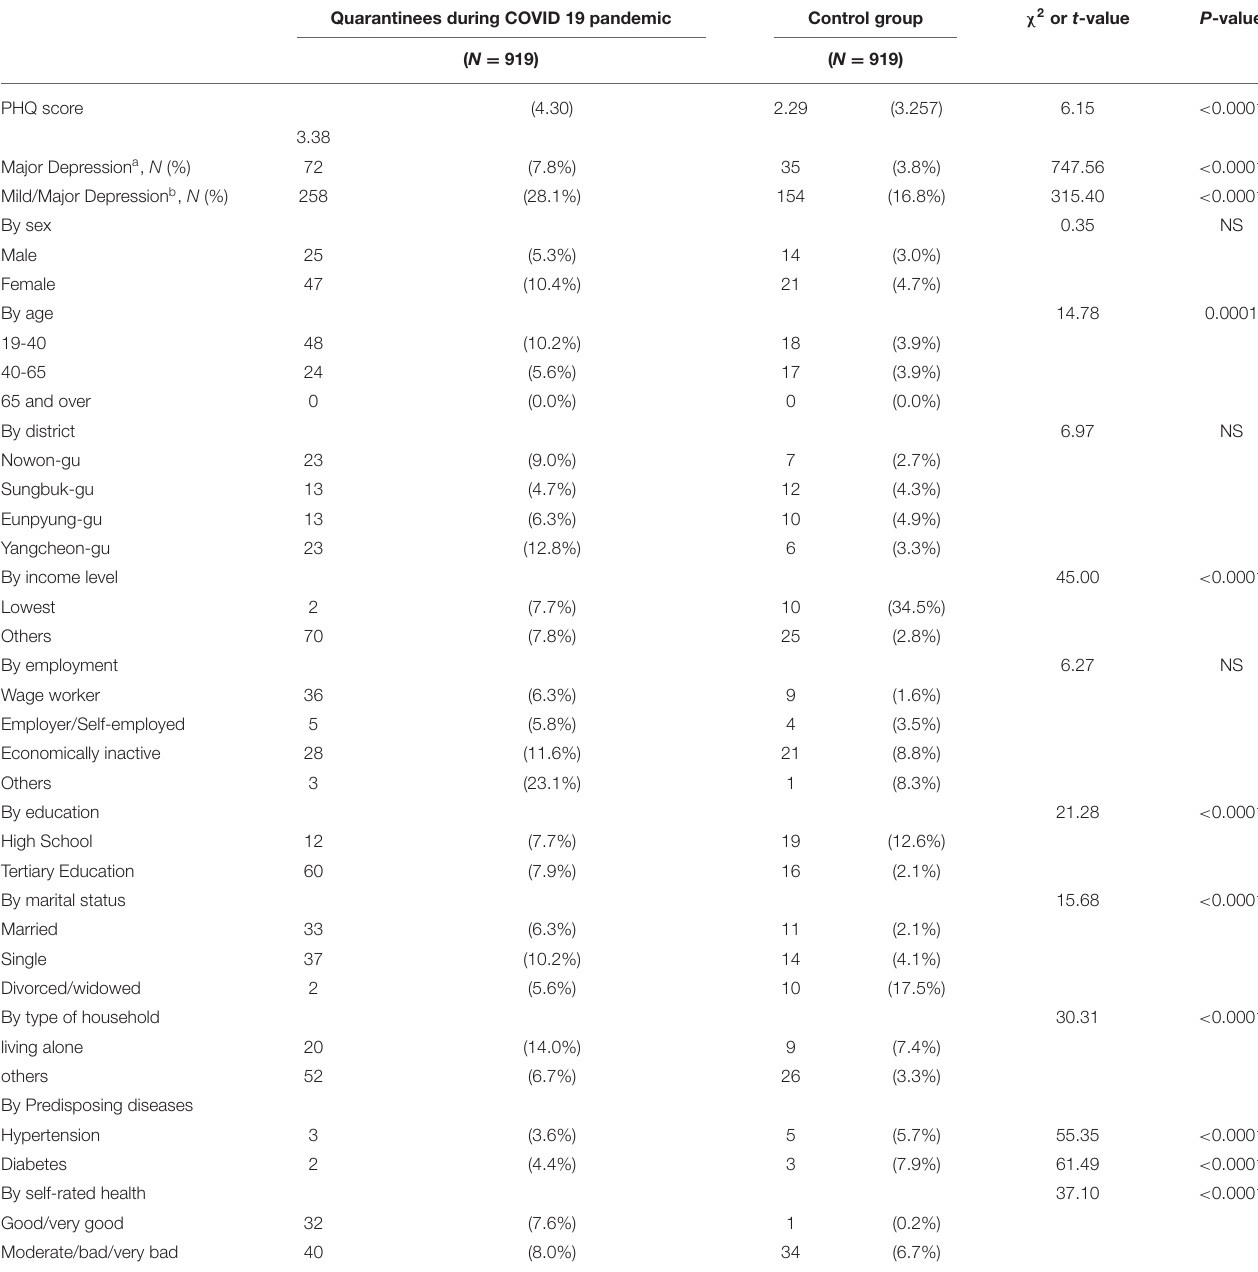
TABLE 2 | Distribution of depression-related measures among quarantined individuals during the COVID-19 pandemic and the control group. Quarantinees during COVID 19